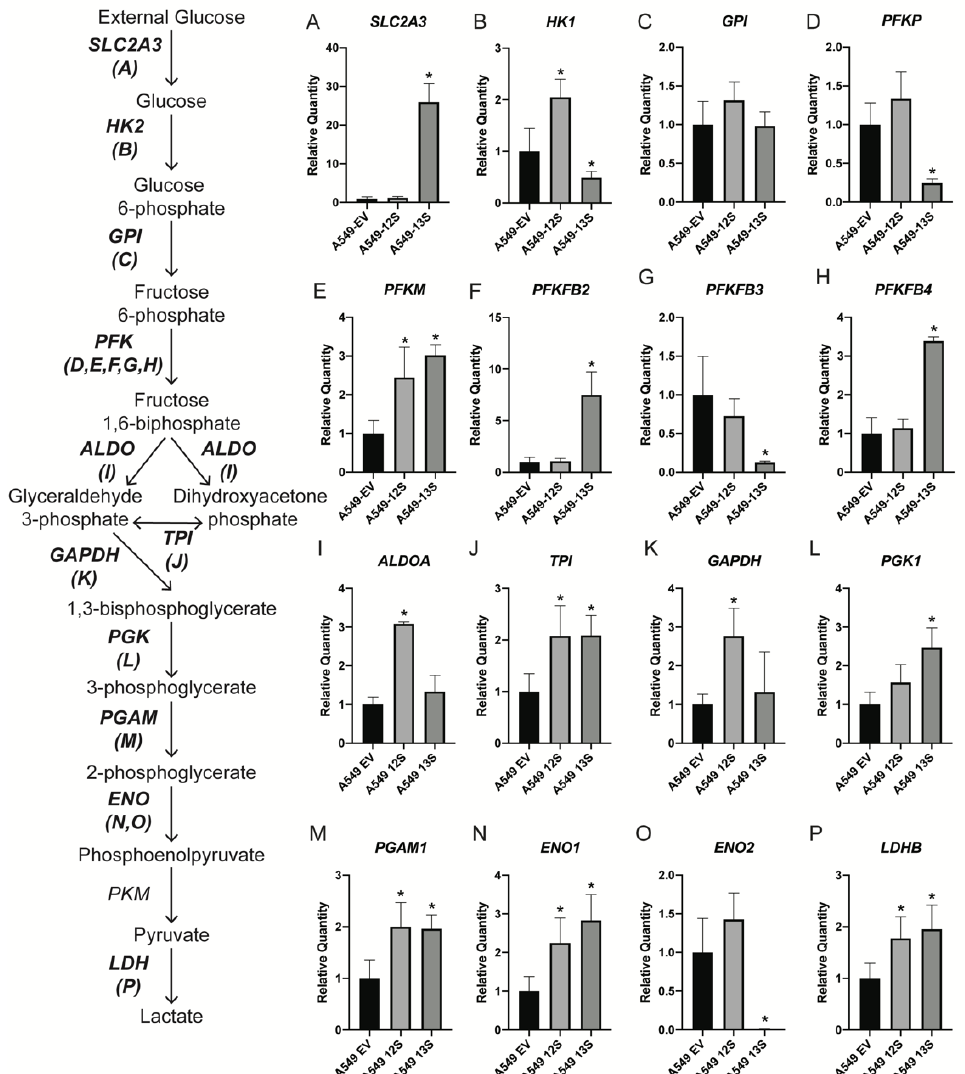
Figure 2. Relative expression levels of mRNA for glycolytic genes in 13S and 12S expressing A549 cells. The mRNA expression for 16 genes encoding components of glycolysis were measured with qPCR ( A – P